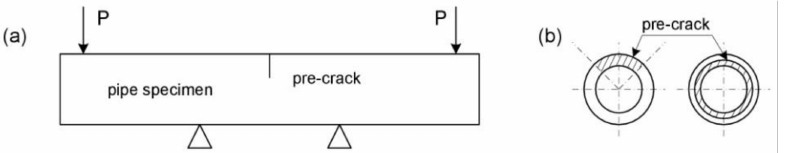
Figure 9. ( a ) Four-point bending test of a pipe; ( b ) geometry of initially introduced cracks, data from